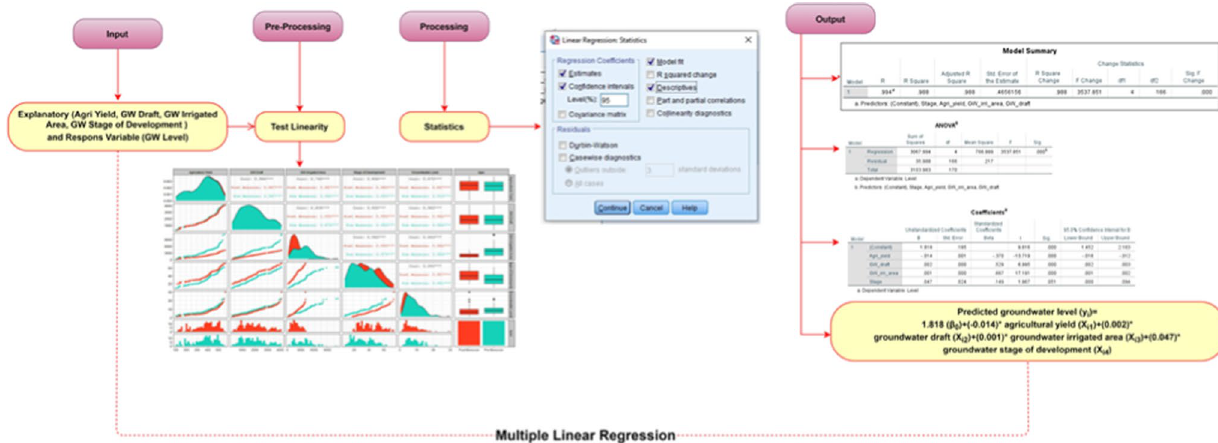
Fig. 15 Schematic presentation of multiple linear regression with input, processing and output of this study